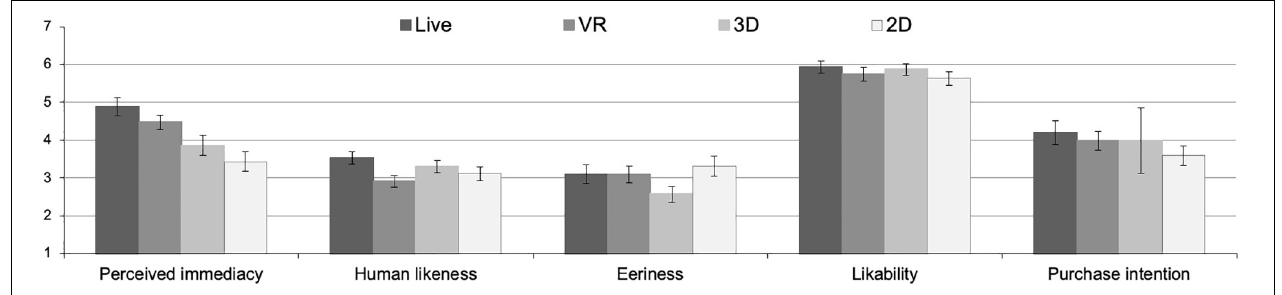
FIGURE 3 | Perceived immediacy, human likeness, eeriness, likability and purchase intentions under the four experimental